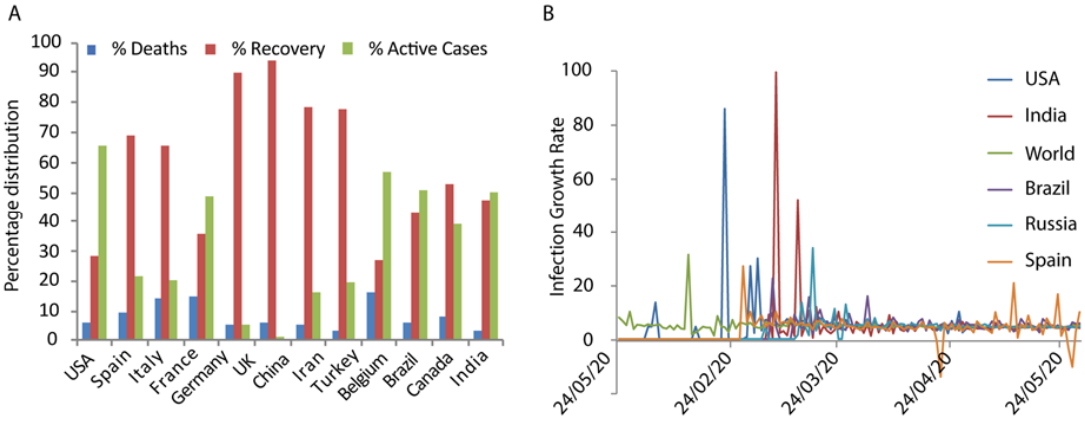
Figure 1. ( A ) Percentage distribution of number of deaths, recovery and active cases in worst-hit countries in the world. ( B ) Infection growth rate of some of the worst infected countries is shown. The data represent quite a linear growth.